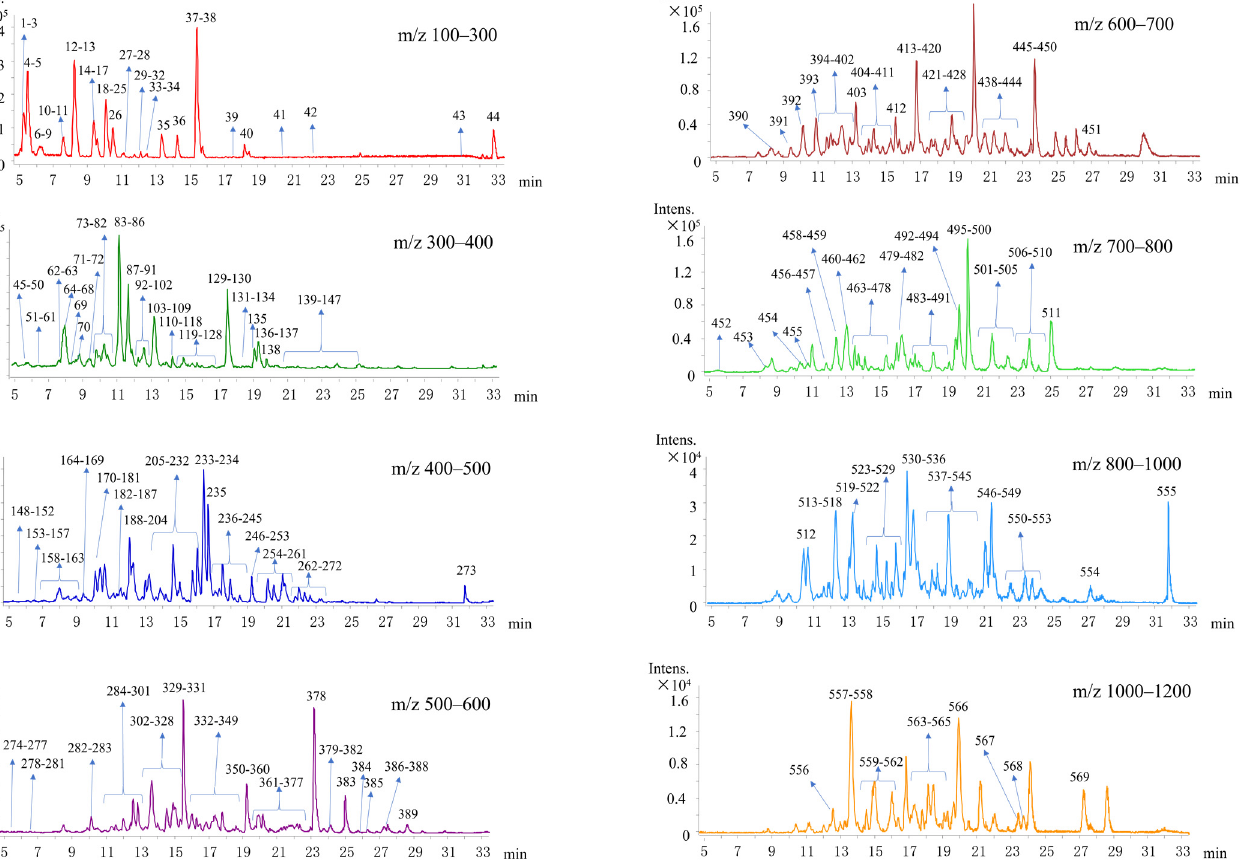
Figure 2. Selected ions from LC-Q-TOF-MS base peak chromatograms (BPC) in the scan range of m / z 100–1200 of the trypsin hydrolysates of the reference material of donkey skin gelatin.